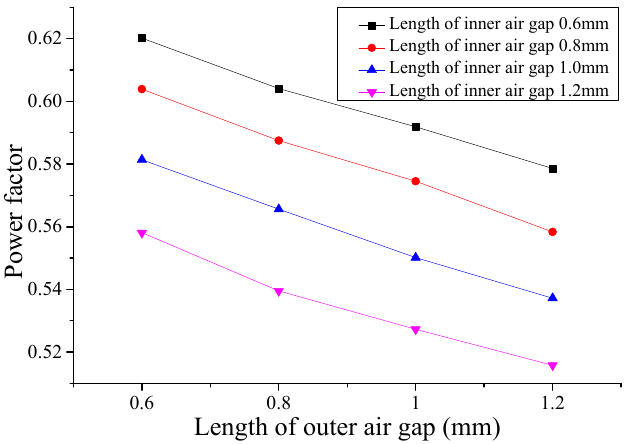
Figure 14. Variation of power factor versus length of outer/inner air